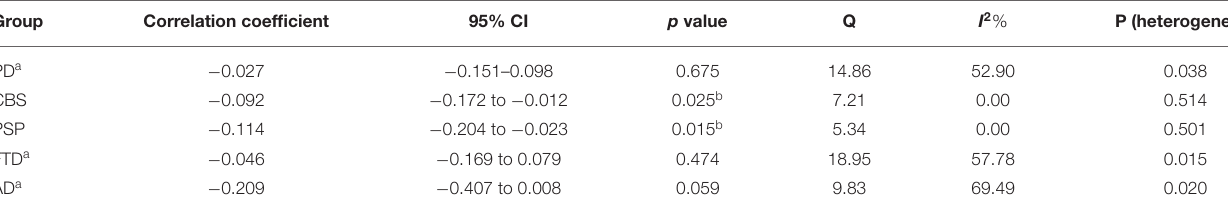
Group Correlation coefficient 95% CI p value Q I 2 % P